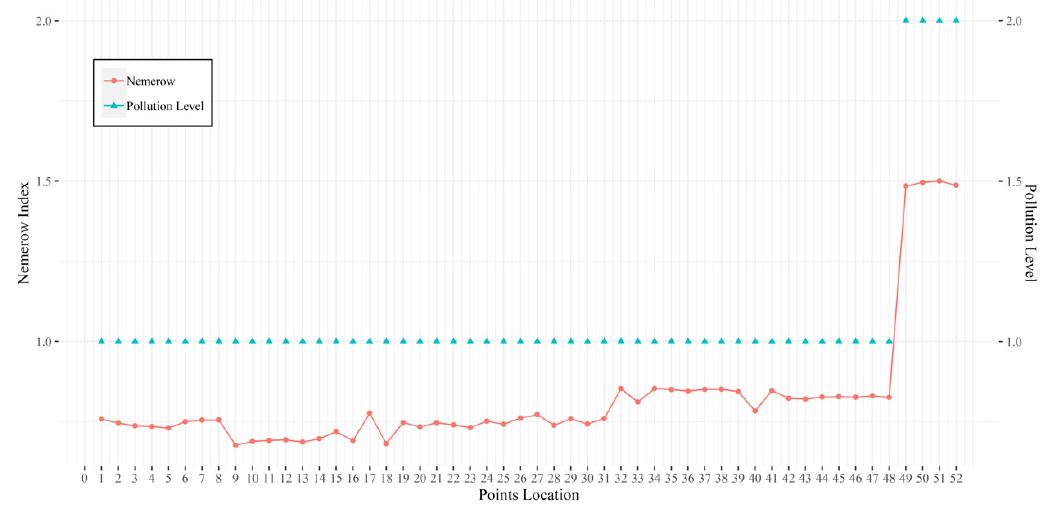
Figure 4. Manual interpretation of the pollution level and corresponding NCPI in study